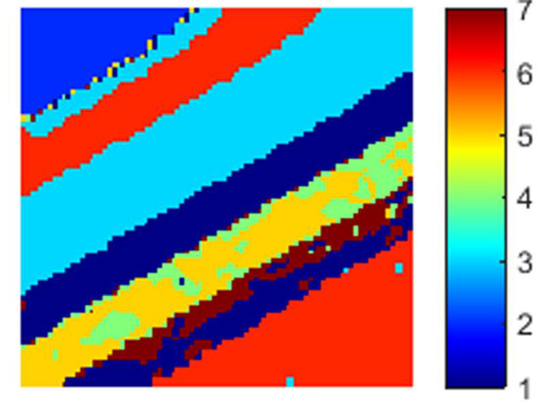
Figure 10: Salinas A solutions obtained by KCA algorithm.